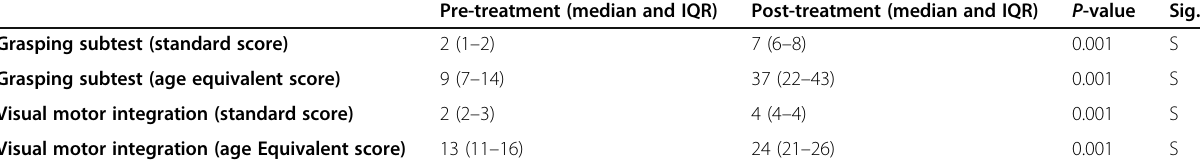
Table 3 Comparison of pre-treatment and post-treatment results of the study group